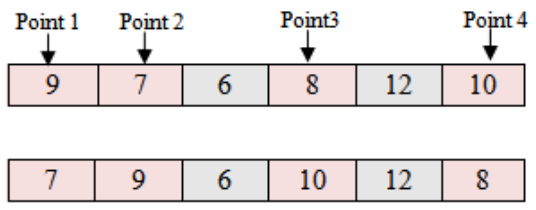
Figure 5. Search for predators’ approach.